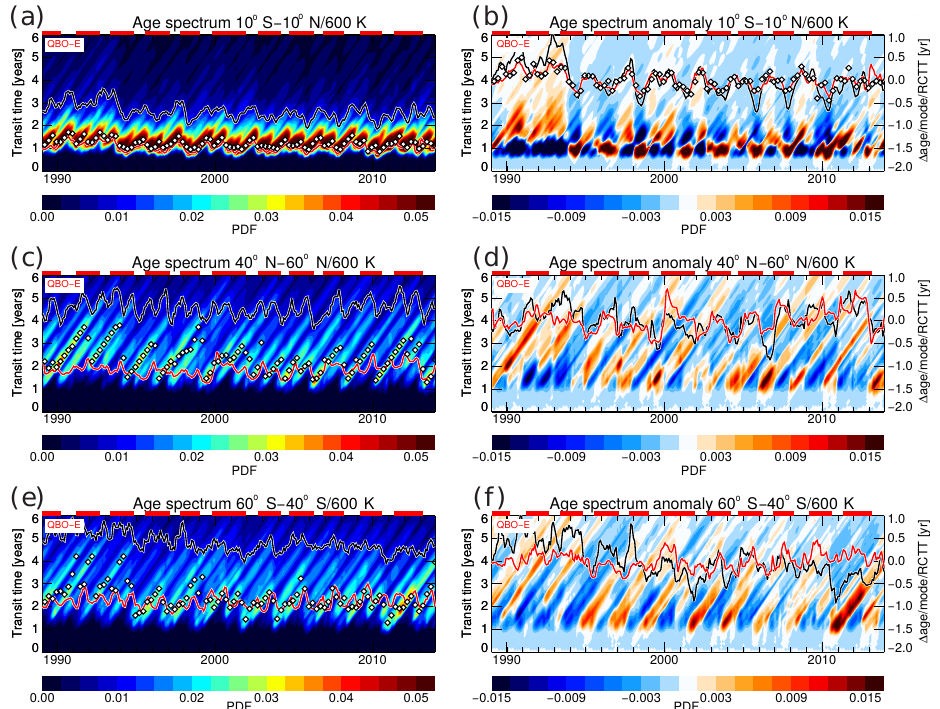
Figure 13. Age spectrum time series at 600K and 10 ◦ S–10 ◦ N (top), 40–60 ◦ N (middle), and 60–40 ◦ S (bottom). Shown are the spectra (left) and their de-seasonalized anomalies (right). Black lines show mean age, symbols modal age, and red lines show RCTT (full values on the left and their respective de-seasonalized anomalies on the right). Red horizontal bars highlight easterly QBO